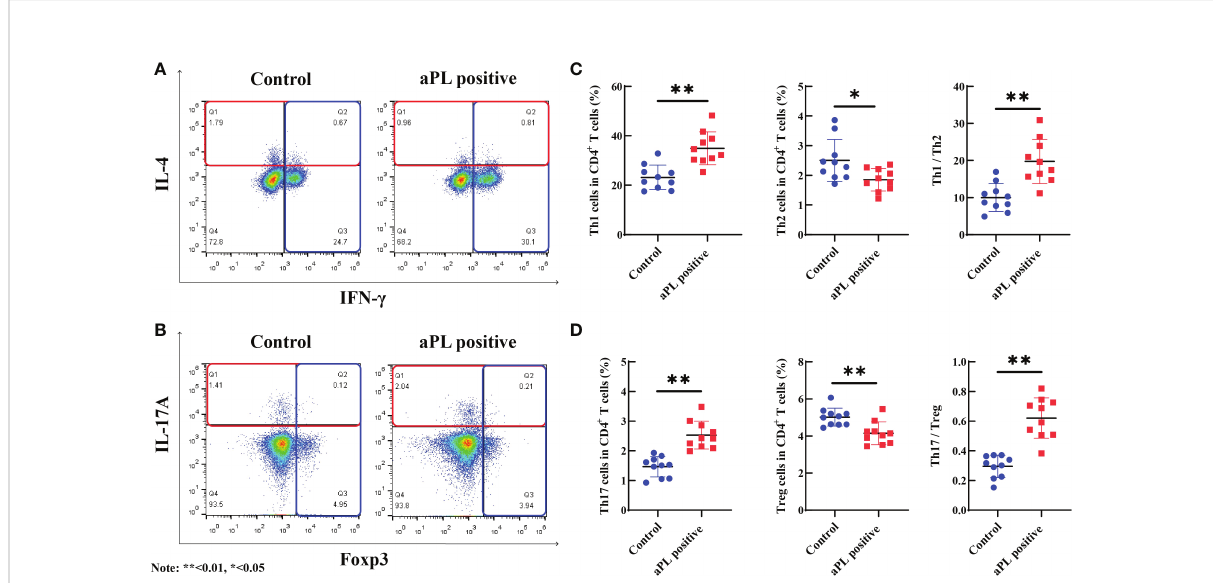
FIGURE 3 The comparison of peripheral blood Th1, Th2, Th17, and Treg cells, and Th1/Th2 and Th17/Treg ratios in women with positive (n=10) and negative (n=10) aCL and/or a b 2GPI antibodies (aPL). Women with aPL had signi fi cantly higher levels of peripheral blood Th1 and Th17 cells and signi fi cantly lower levels of peripheral blood Th2 and Treg cells than controls. Th1/Th2 and Th17/Treg ratios were signi fi cantly higher in women with aPL than in controls. (A) The proportion of Th1 and Th2 cells in women with aPL and controls; (B) The proportion of Th17 and Treg cells in women with aPL and controls; (C) Comparison of the proportion of Th1, Th2, and Th1/Th2 ratio between women with aPL and control; (D) Comparison of the proportion of Th17, Treg, and Th17/Treg ratio between women with aPL and controls. **P<0.01, *P<0.05.